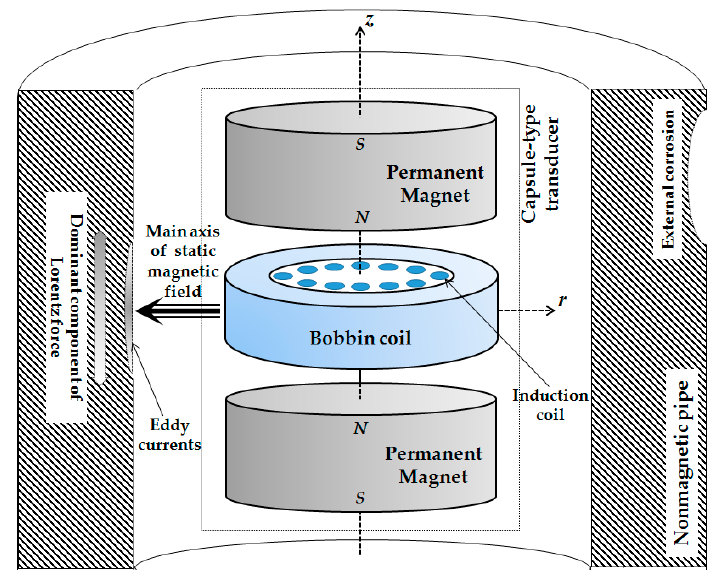
Figure 1. The proposed capsule-type Electromagnetic Acoustic Transducer (EMAT) for pipe inspection.